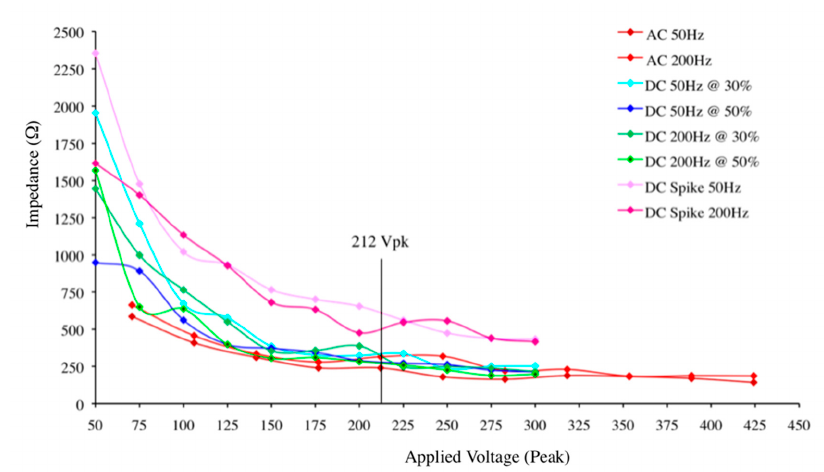
Figure 1. The effect of applied voltage (peak) at different waveforms on the average impedance ( n = 20) of a turkey’s head at 200 ms after start of current flow. AC = Alternating current, DC = Direct current, DC Spike = pulsed DC single voltage spike Table 2. Voltages that are expected to produce an effective stun when applied head ‐ only to turkeys. Waveform Value